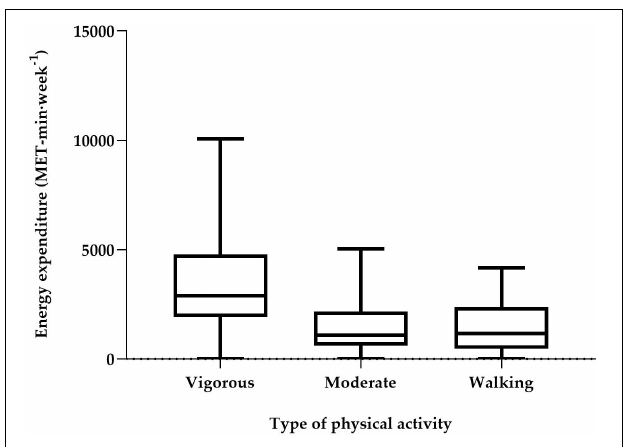
FIGURE 2 | Total energy expenditure (MET-min · week - 1 ) in each type of physical activity, based on IPAQ-SF. Values are median and interquartile range.